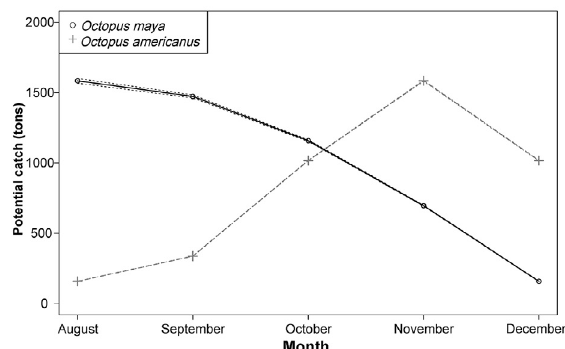
Fig. 6. – Monthly potential catch curves for the 2019 season of O. maya (black) (distribution type I=1) and O. americanus (grey) (distribution type